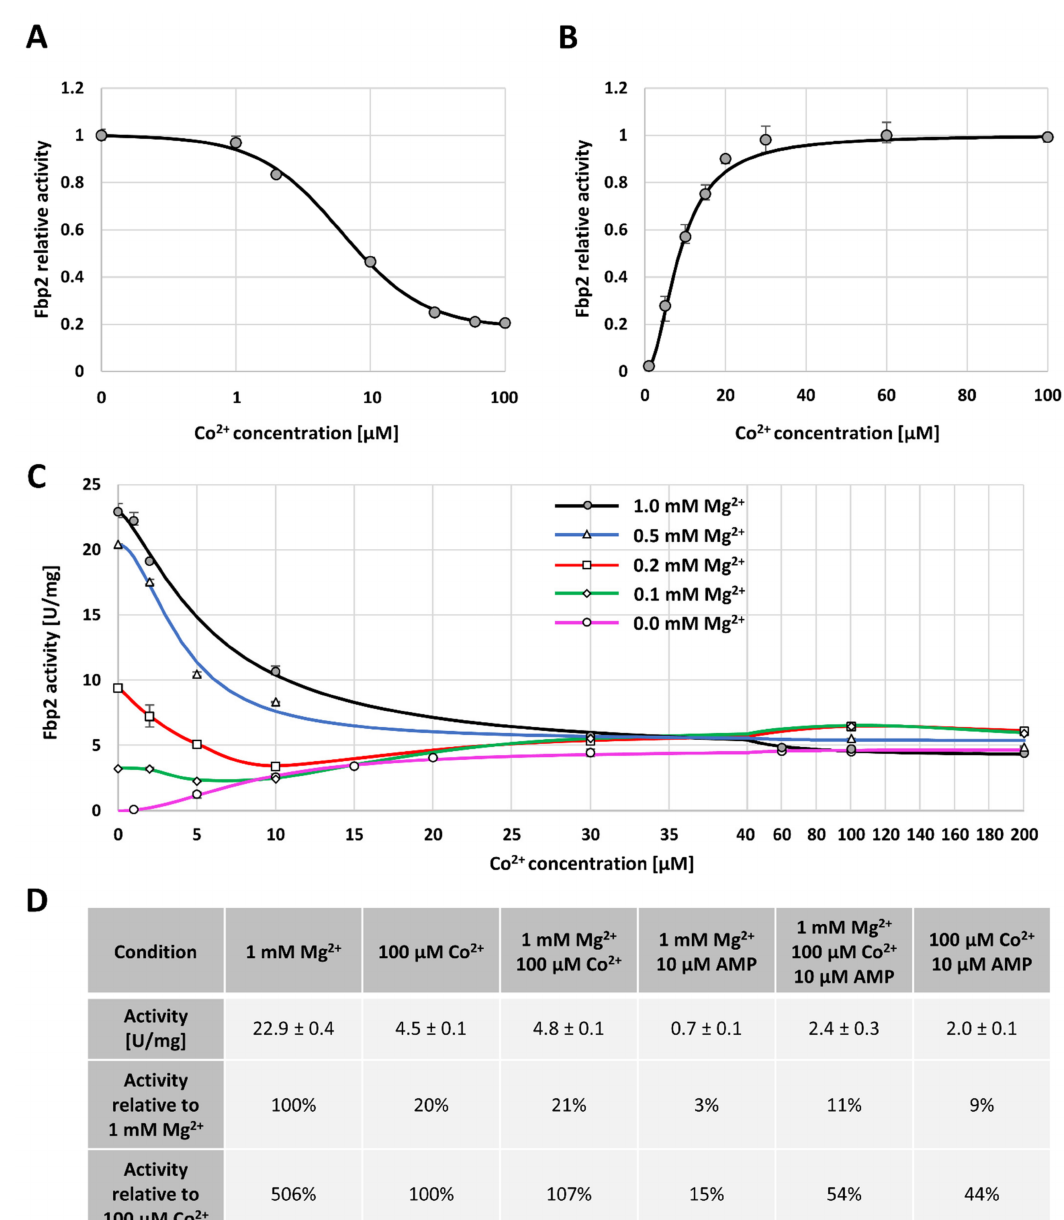
Figure 4. The effect of Co 2+ on Fbp2 kinetics. ( A ) Co 2+ acts as an Fbp2 inhibitor in the presence of catalytic ions (Mg 2+ ) with the maximal inhibition of about 79% and IC 50 value 6.1 µ M, whereas ( B ) in the absence of Mg 2+ , Co 2+ activates Fbp2 with the AC 50 value of 8.6 µ M. ( C ) Co 2+ acts in a cooperative manner competing with Mg 2+ for binding to the active site of Fbp2. ( D ) Comparison of the Fbp2 enzymatic activity in the presence of Co 2+ , AMP, and both the